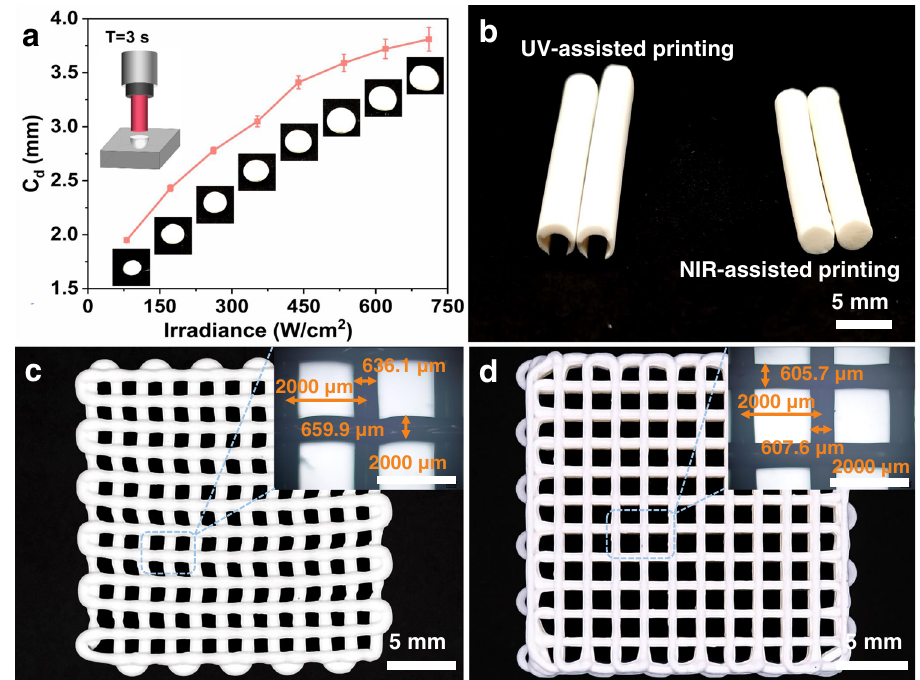
Fig. 2 | The differences between varied photopolymerizationconditions.a The depthofthephotocuredslurryasafunctionofdifferentNIRintensityataconstant exposuretime of3s. The top inset is a schematicdiagram of the curing depth test. The bottom inset is the actual cured objects obtained by curing for 3s under different NIR light intensities. The curing depths (C d ) are the heights of the actual